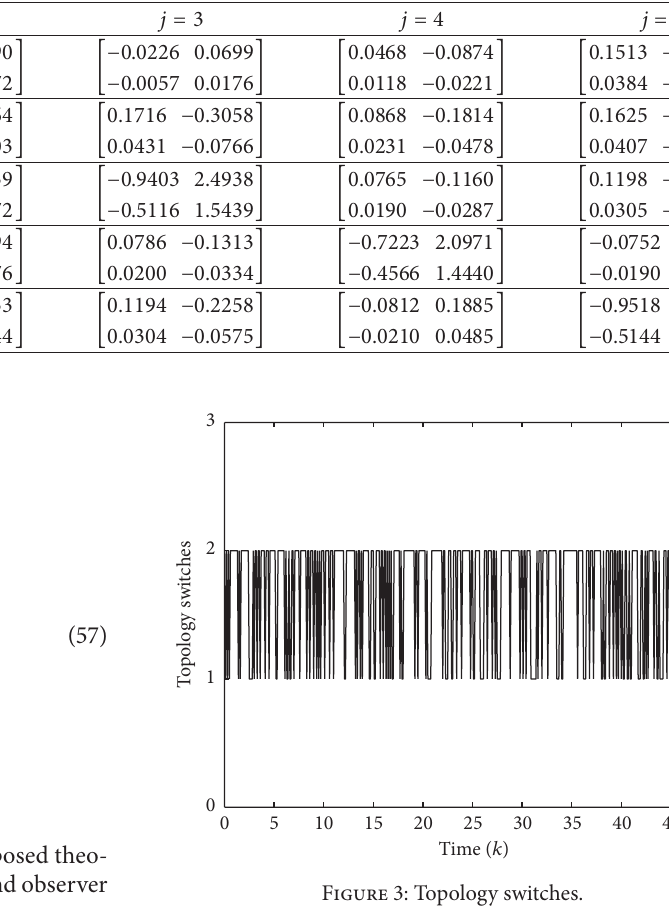
Table 1: Gain matrices.